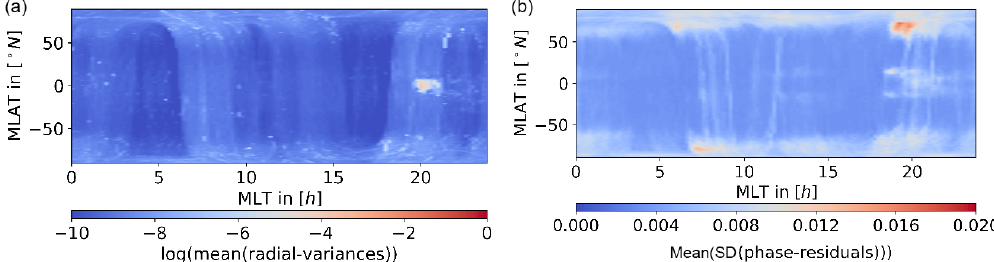
Figure 3. Radial variances (a) and spreading of phase residuals (b) binned in magnetic coordinates for the analyzed test period, 2015: January, March; 2016: February, March, June, July, August.